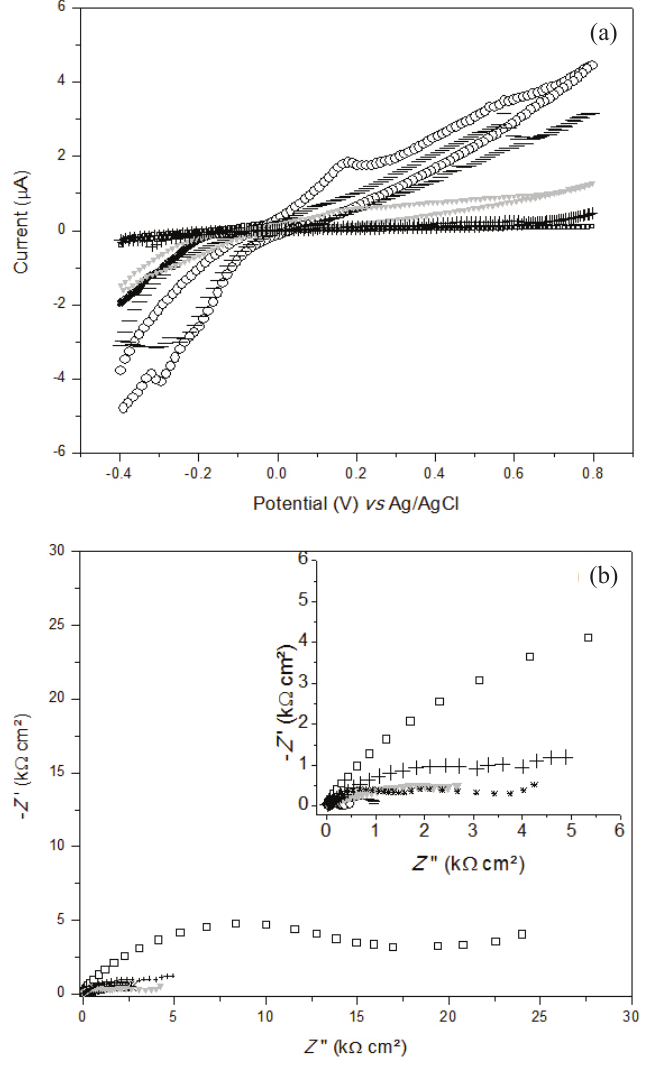
Fig. 5 – EIS spectrum (a) with inset up to 6 kΩ cm² and cy- clic voltammogram (b) of the